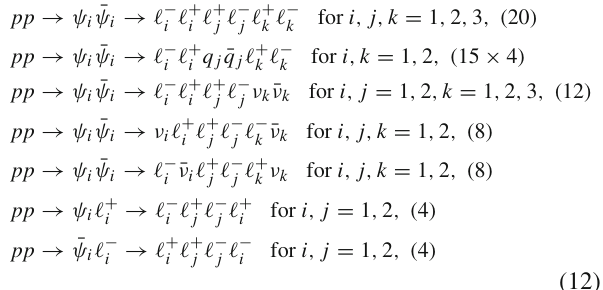
Fig. 4 Examples of signal channel Feynman diagrams with at least four light leptons in the final state in the singlet (2) and doublet (4) model. Only first- and second-generation vector-like leptons can con-